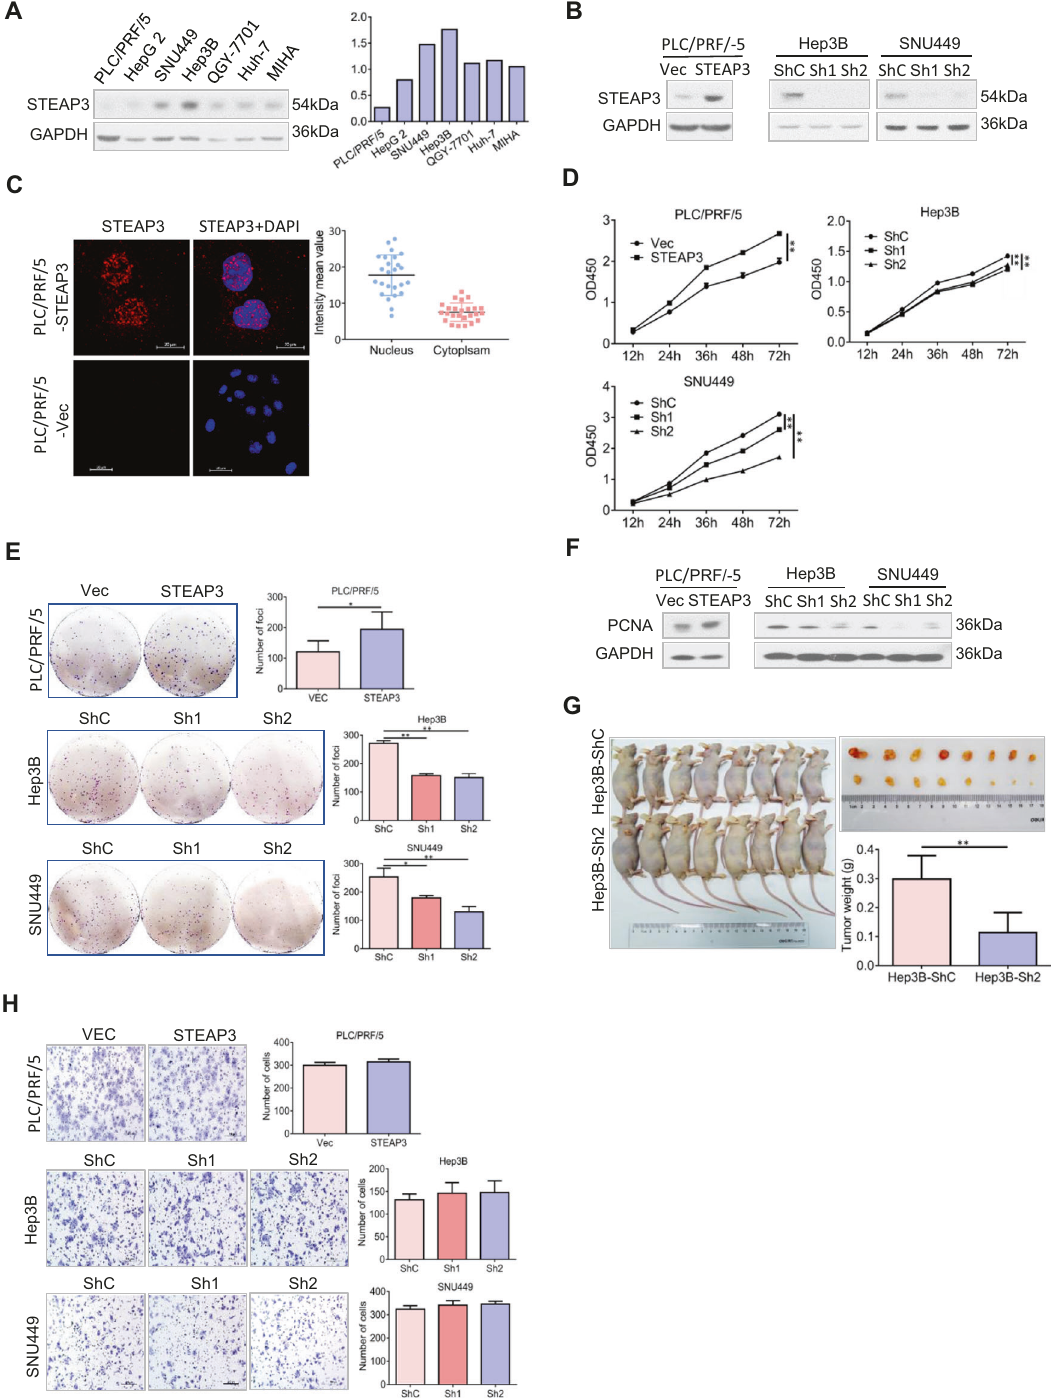
Fig. 2 Enhanced nuclear expression of STEAP3 promotes cancer cell proliferation in HCC. A Expression levels of STEAP3 were examined by western blot in HCC cell lines (PLC/PRF/5, HepG2, SNU449, Hep3B, QGY-7701, and Huh-7) and immortalized hepatocyte (MIHA). B STEAP3 was stably overexpressed in PLC/PRF/5-STEAP3 or knocked down in Hep3B-ShSTEAP3 and SNU449-ShSTEAP3, and veri fi ed by western blot. C Subcellular distribution of STEAP3 (red) was examined by IF in PLC/PRF/5-STEAP3 and control cells. Fluorescence intensity mean values of STEAP3 in the nuclei and cytoplasm were measured in randomly selected 25 cells in PLC/PRF/5-STEAP3. Nuclei were visualized by DAPI (blue). Scale bar, 20 μ m. p < 0.01. D Cell viability was examined by CCK8 assays. Data are presented as means ± SD of three independent experiments in triplicates. ** p < 0.01. E Cell proliferation was monitored by colony formation. Data are presented as means ± SD of colony foci of three independent experiments. * p < 0.05, ** p < 0.01. F PCNA levels were examined by western blot. G A subcutaneous xenograft tumor mouse model was carried out by injecting Hep3B-ShC and Hep3B-ShSTEAP3-2 into two groups of nude mice, respectively (left). Tumor masses were weighed (right). Data are presented as means± SD. ** p < 0.01. H Cell mobility was determined by transwell chamber assays. Data are showed as mean ± SD of three independent experiments. Scale bar, 200 μ m. p >